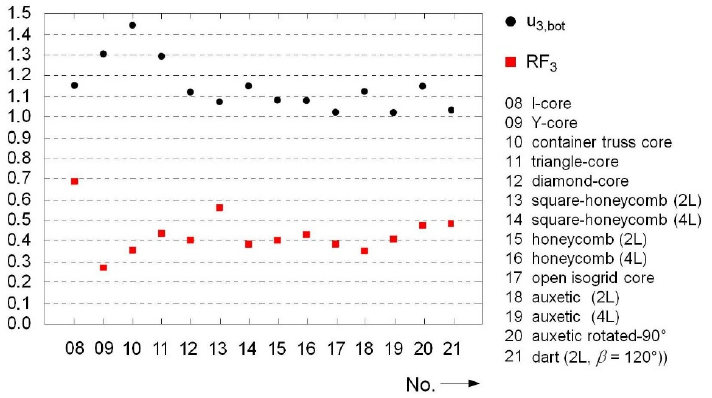
Figure 22. Prismatic cores: normalized maximum values for displacement u 3,bot and reaction force RF 3 .